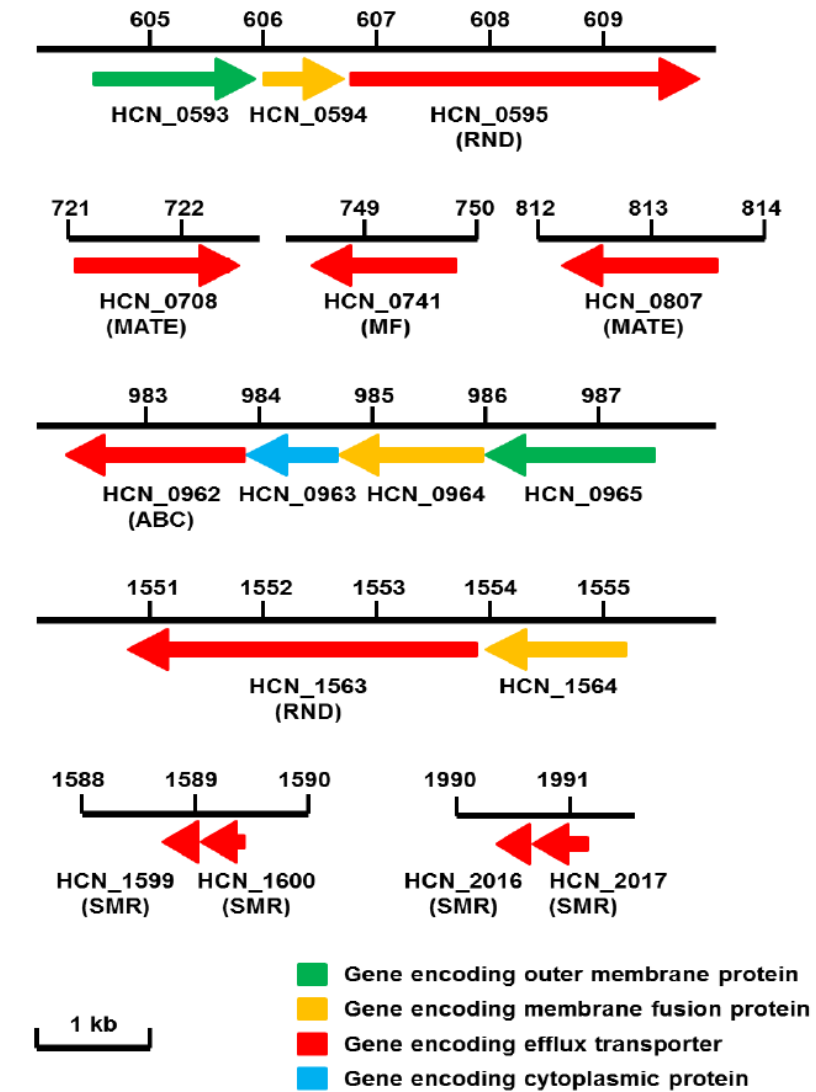
Figure 1. Drug efflux genes encoded in the genome of H. cinaedi PAGU 611. Chromosomal positions of drug efflux genes coding for putative inner membrane efflux transporters (red), outer membrane proteins (green), membrane fusion proteins (orange), and cytoplasmic proteins (light blue) are indicated by the kb (kilobase pair) in the H. cinaedi PAGU 611 genome [22]. Arrows correspond to the lengths and directions of the